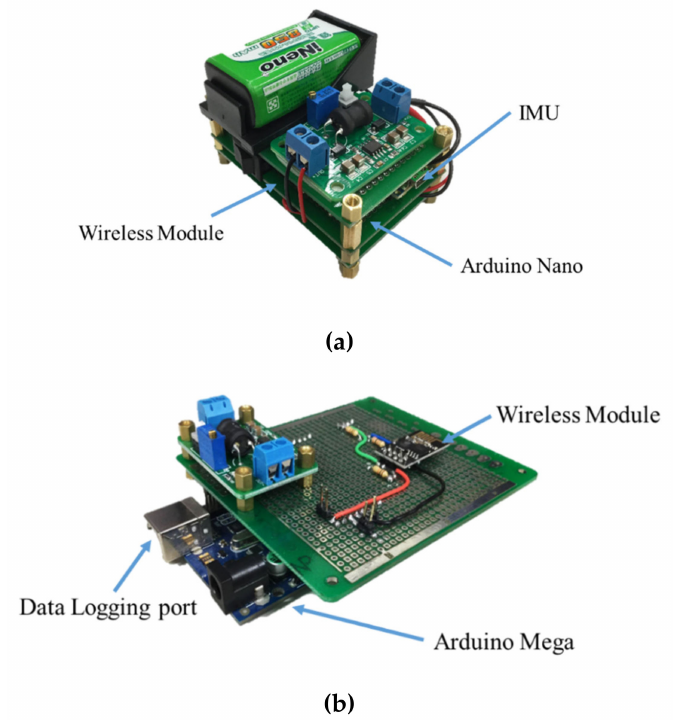
Figure 2. The gait detection system. ( a ) The measurement unit; ( b ) the data logging unit.